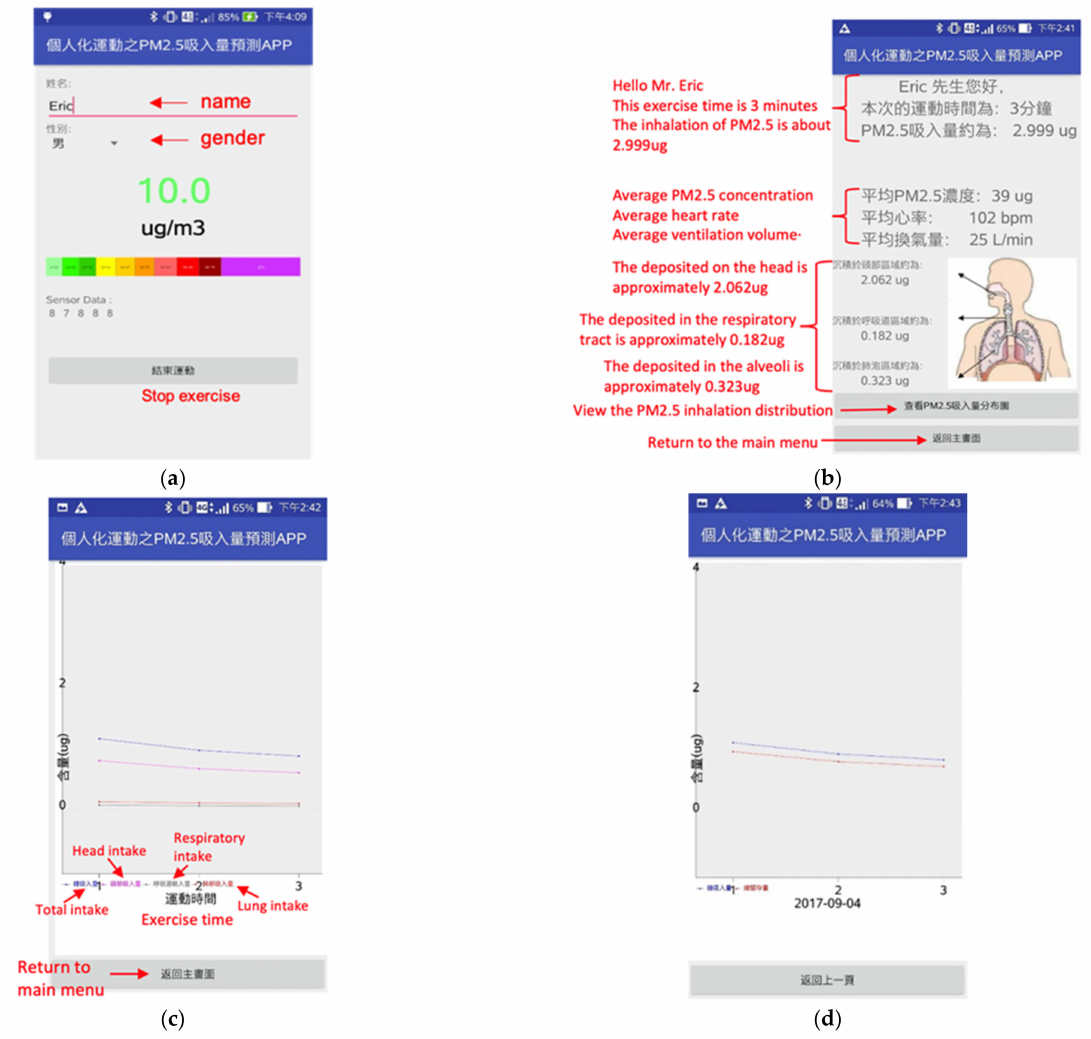
Figure 3. The snapshot of implementation result. ( a ) The current PM 2.5 concentration value displayed once exercise is started; ( b ) The calculation results of PM 2.5 inhalation/retention; ( c ) Results of PM 2.5 inhalation per minute; ( d ) The historical record of the exercise (PM 2.5 inhalation and retention per